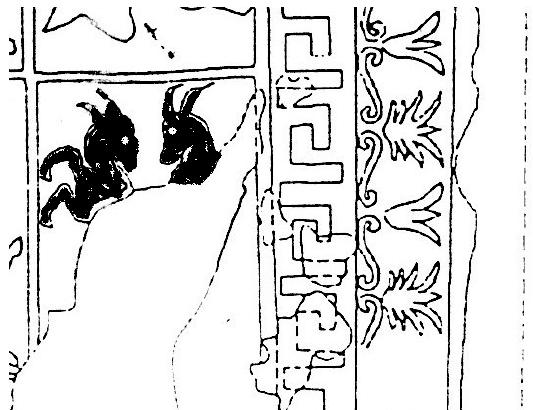
Figure 15. Container in the shape of goat (MGW inv. no. 2450); ceramic vessel; from Birgi, Trapani; ca. 3rd–2nd century BCE .